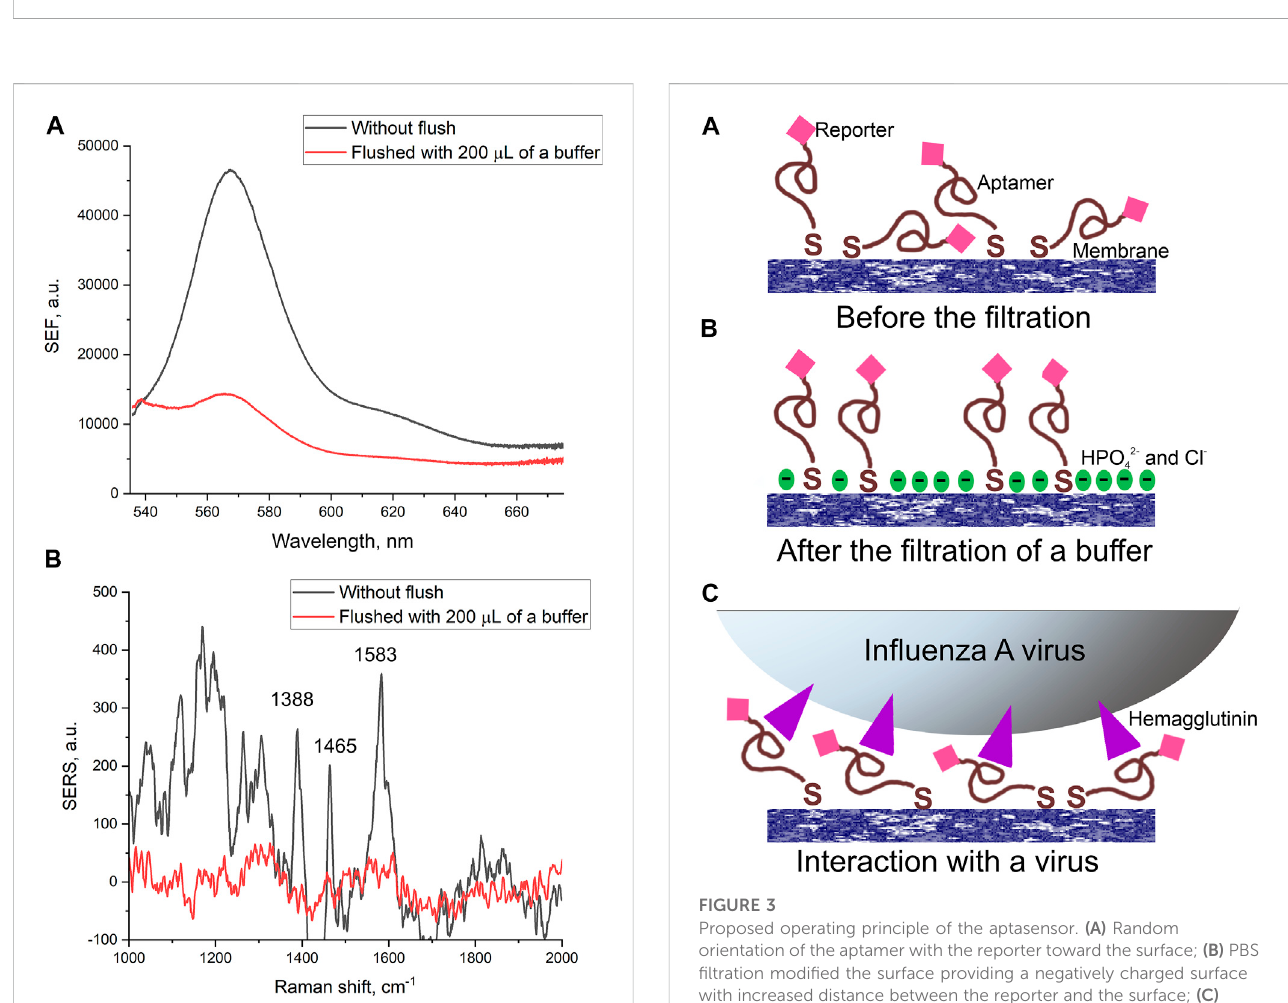
FIGURE 2 Surface-enhanced fl uorescence (A) and surface-enhanced Raman (B) spectra of Cyanine-3 reporter obtained from the track-etched membranefunctionalizedwiththeaptamerbeforeandafterthe fi ltration of phosphate-buffered saline. (10 mM tris-HCl, 140 mM NaNO 3 and 10 mM KNO 3 ) were tested. The highest SEF intensity was achieved for the membrane functionalization with the aptamer solution in PBS.